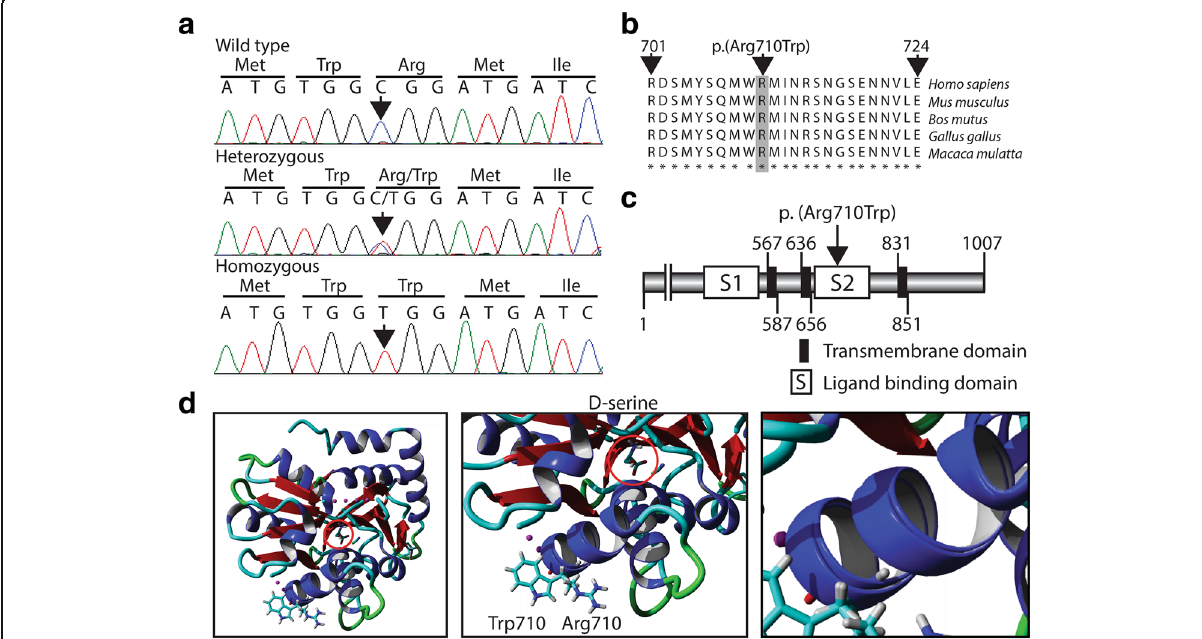
Fig. 2 Analysis of the GRID2 variant and 3D modeling of GluD2. ( a ) Sequence chromatogram of genomic DNA showing part of the GRID2 gene obtained from the healthy sibling IV:5 (top), the heterozygous mother (middle) and a homozygous affected individual IV:2 (bottom). Arrows indicate the position of the c.2128C> T transition. ( b ) Degree of conservation of the Arg710 residue (shaded, bottom) across different species. ( c ) Relative position of the p.(Arg710Trp) substitution in the second extracellular serine-binding domain of the GRID2 protein. NH 2 : N-terminus; COOH: C-terminus. ( d ) Overview of the 3D structure of GluD2 protein with D-serine circled in red (left box). Enlargement of the D-serine binding domain of GluD2 with juxtaposition of the w.t. (p. Arg710) and the mutated (p.Trp710) residues at position 710 (middle box). The p.Arg710Trp substitution predicts a slight conformational change in the α -helix of the ligand binding domain (right box). The position of D-serine is circled in